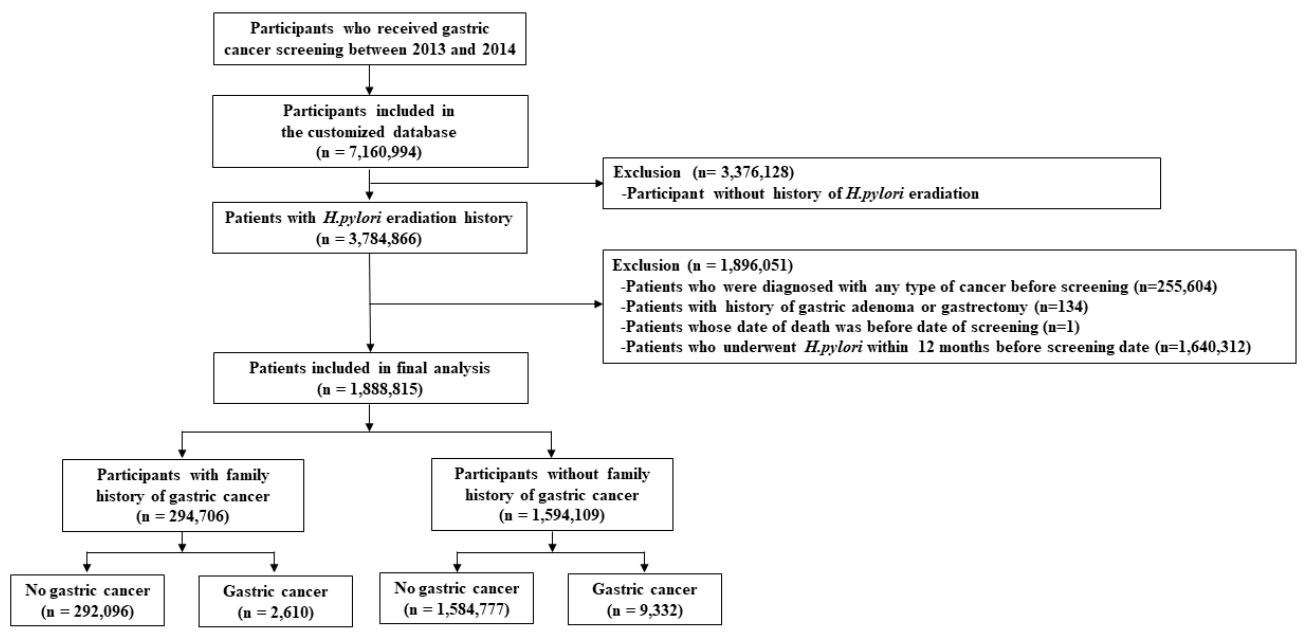
Figure 1. Flowchart for the selection of the study population. H. pylori, Helicobacter pylori.